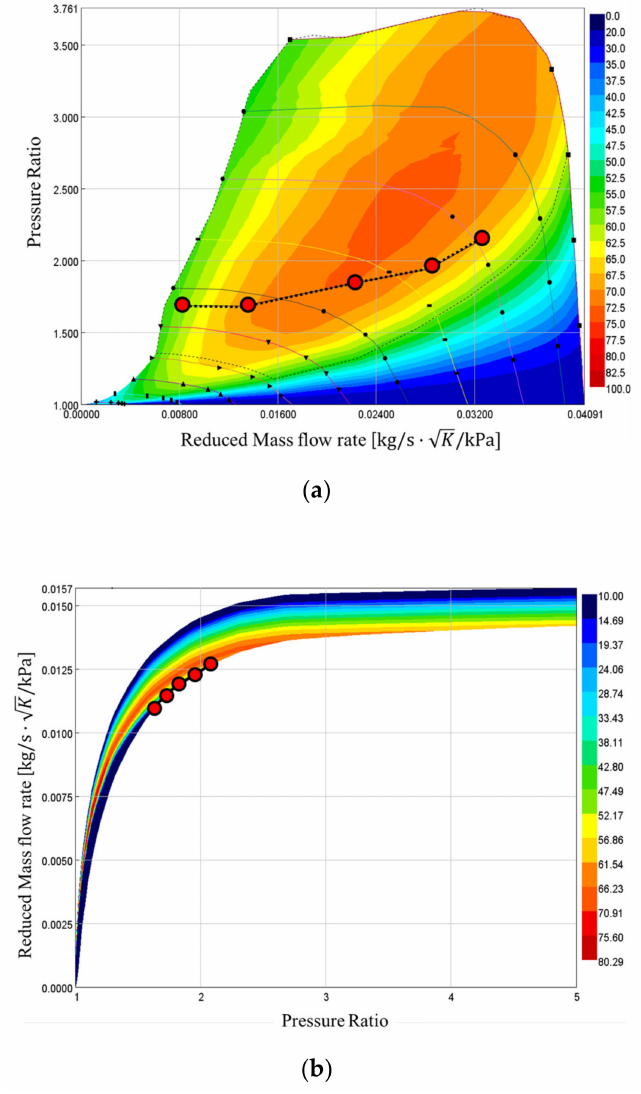
Figure 6. Performance of selected turbocharger: ( a ) Compressor map; ( b ) turbine